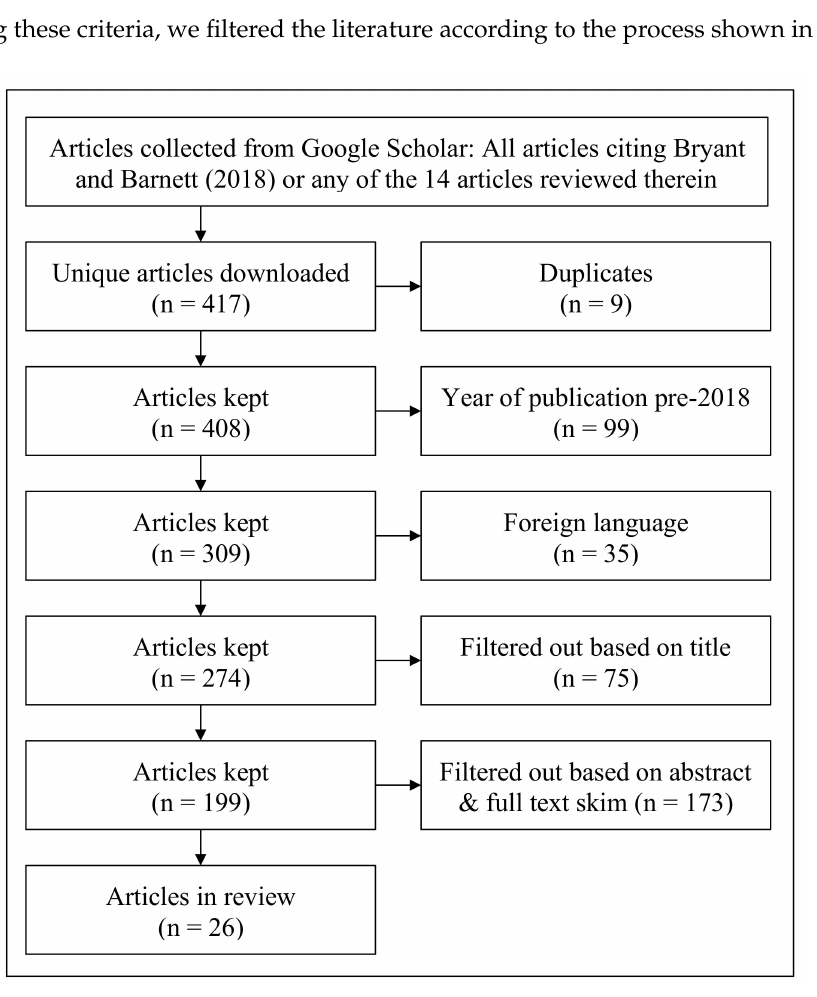
Figure 1. Process for identifying the relevant